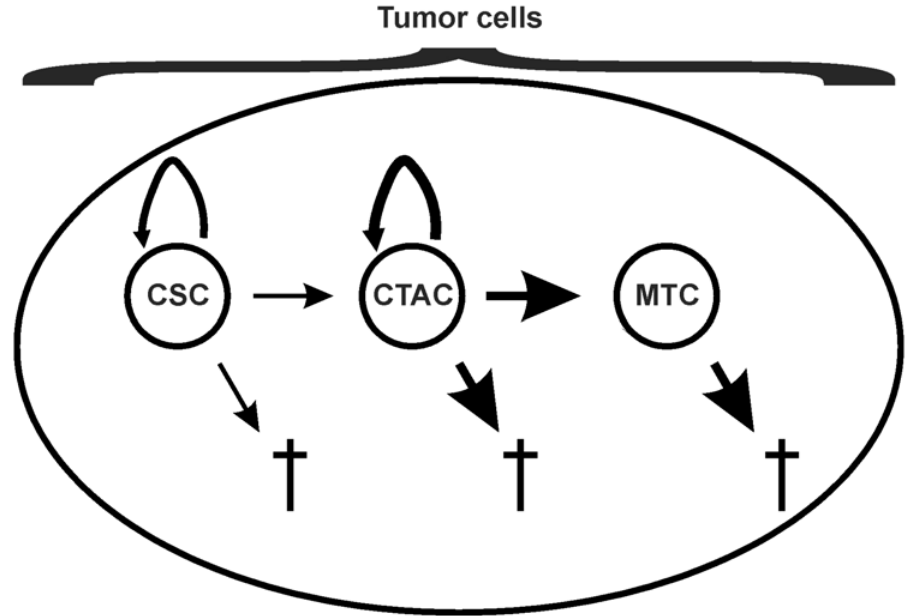
Fig 2. The tumor cell compartments of the model. The model assumes three types of tumor cells. In addition to mature tumor cells (MTC), cancer stem cells (CSC), and cancer transit amplifying cells (CTAC) are assumed. CTAC represent the major proliferating population of tumor cells with high differentiation capacity. Without replenishment from the CSC pool, this population will completely differentiate into MTC. CSC are considered as small population with low proliferative activity but high self-renewal capacity. All cell populations are continuously lost by natural cell death which is more pronounced in MTC and CTAC than in